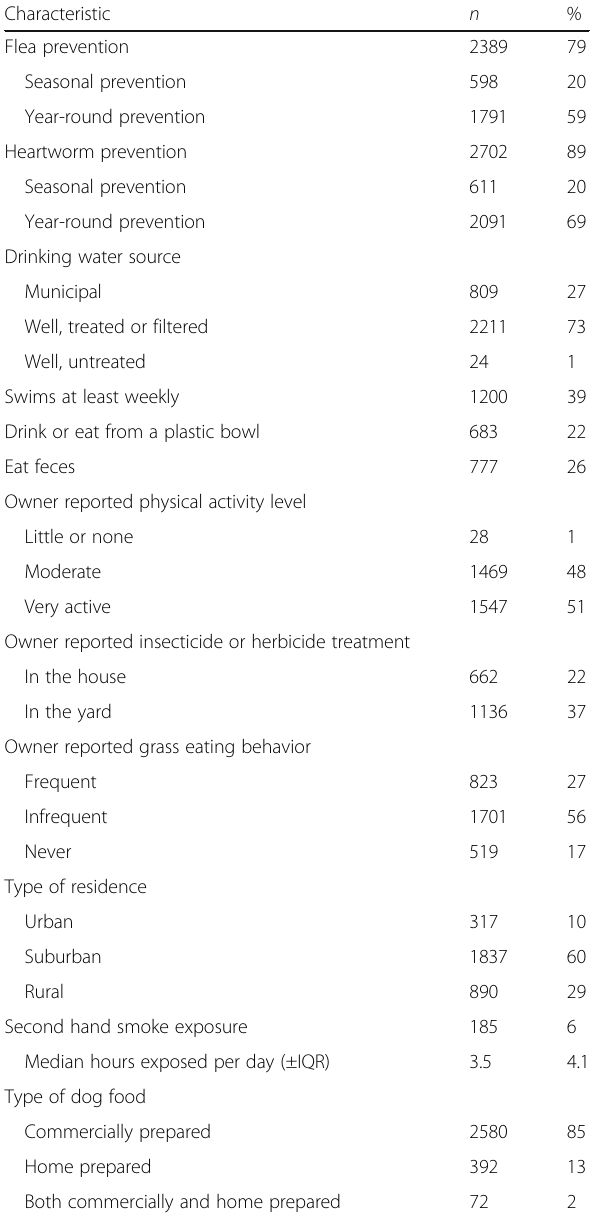
Table 2 Owner-reported environmental and lifestyle exposures among 3044 Golden Retriever Dogs at the time of first owner